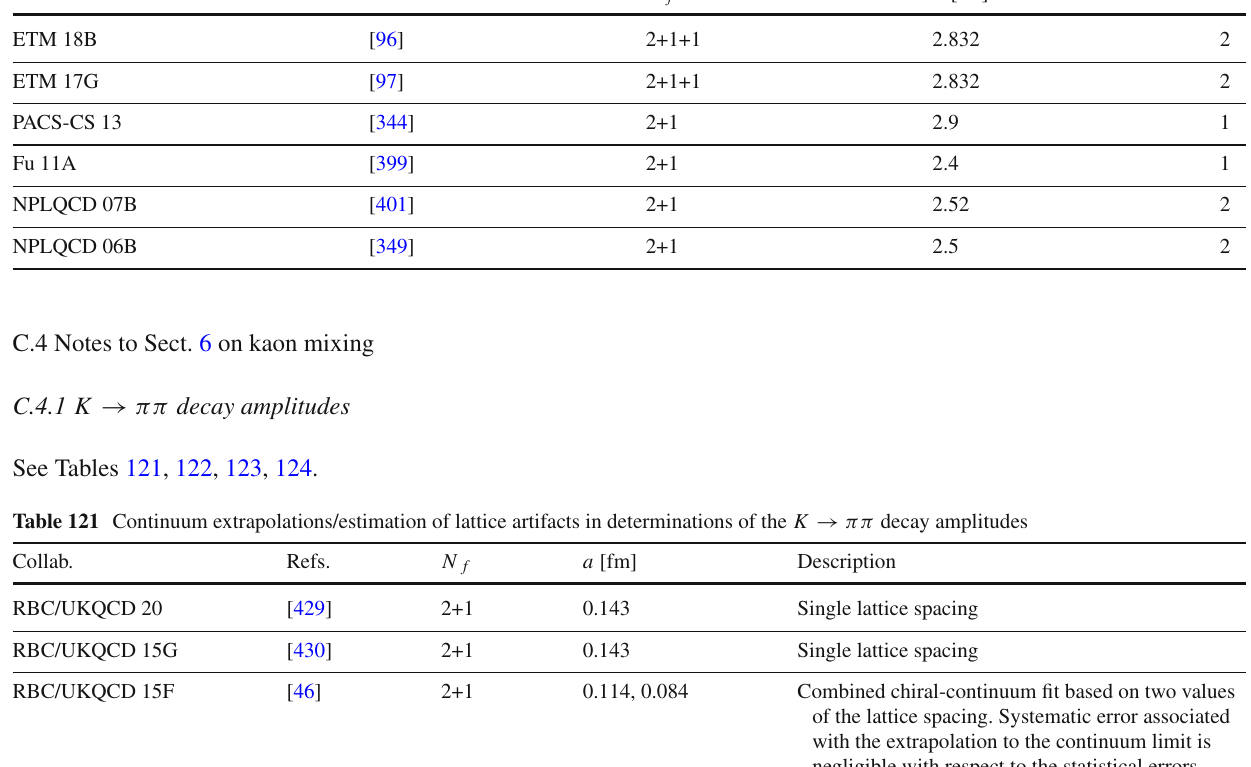
Table 122 Chiral extrapolation/minimum pion mass in determinations of the K → ππ decay amplitudes Collab.